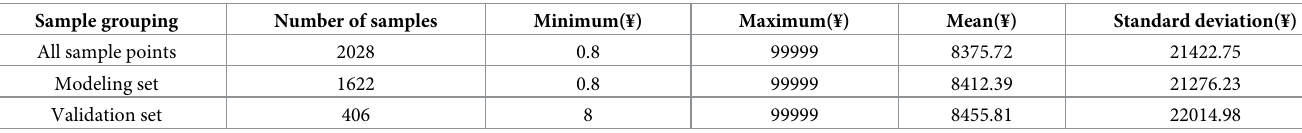
Table 2. Statistics on descriptive characteristics of tea prices in the study